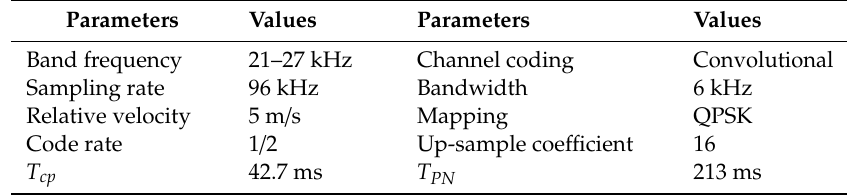
Table 1. Simulation parameters of the pseudo-noise sequence-based underwater acoustic orthogonal signal division multiplex (OSDM) communication system (UWAOSDM /